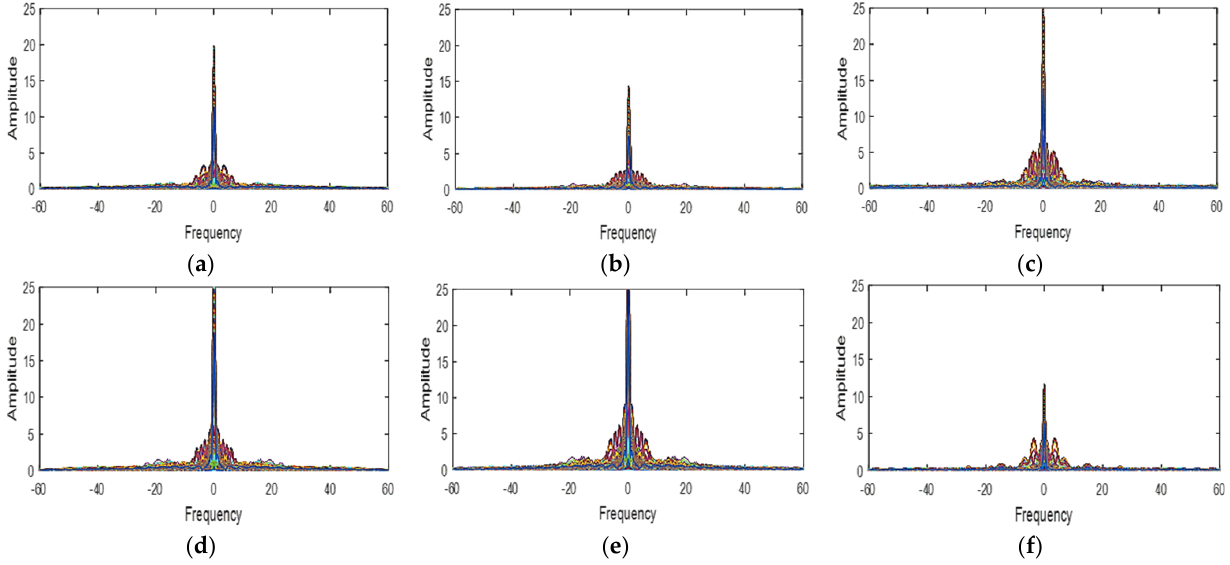
Figure 6. The power spectrum functions of the gradient signal in beers image ( a ) green − red ( b ) green − blue ( c ) green − orange ( d ) red − blue ( e ) red − orange ( f ) blue − orange.